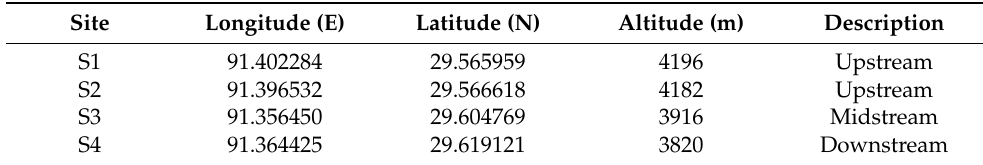
Table 1. Sampling